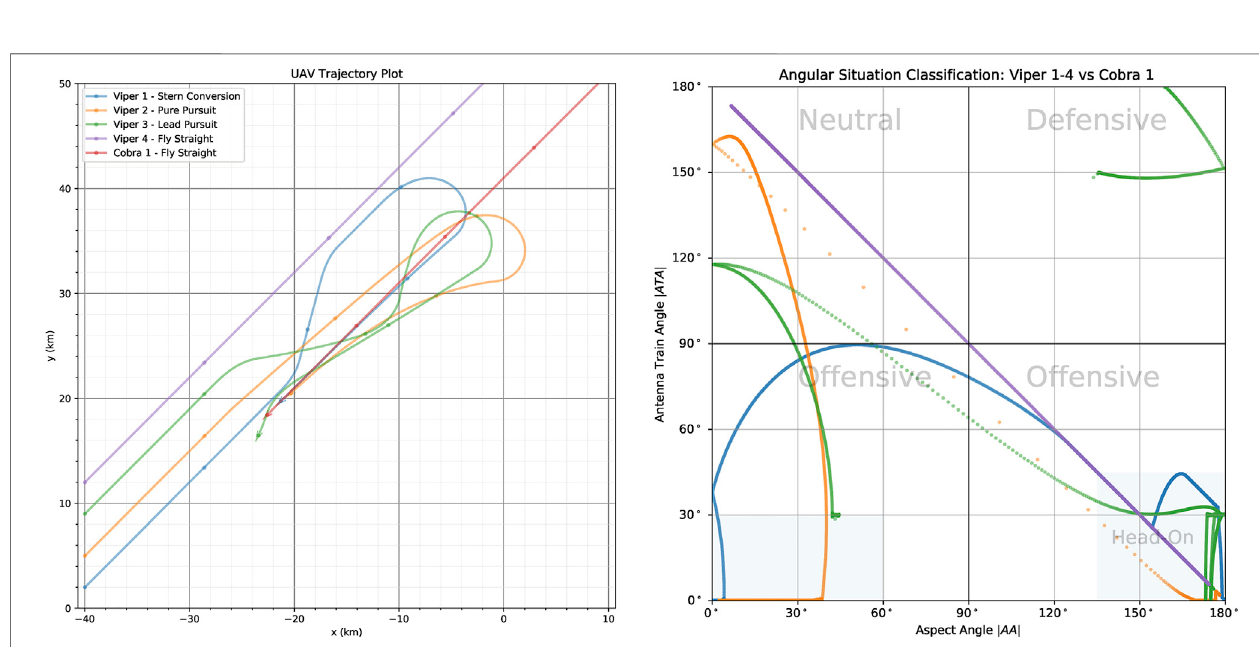
Frontiers in Arti fi cial Intelligence |